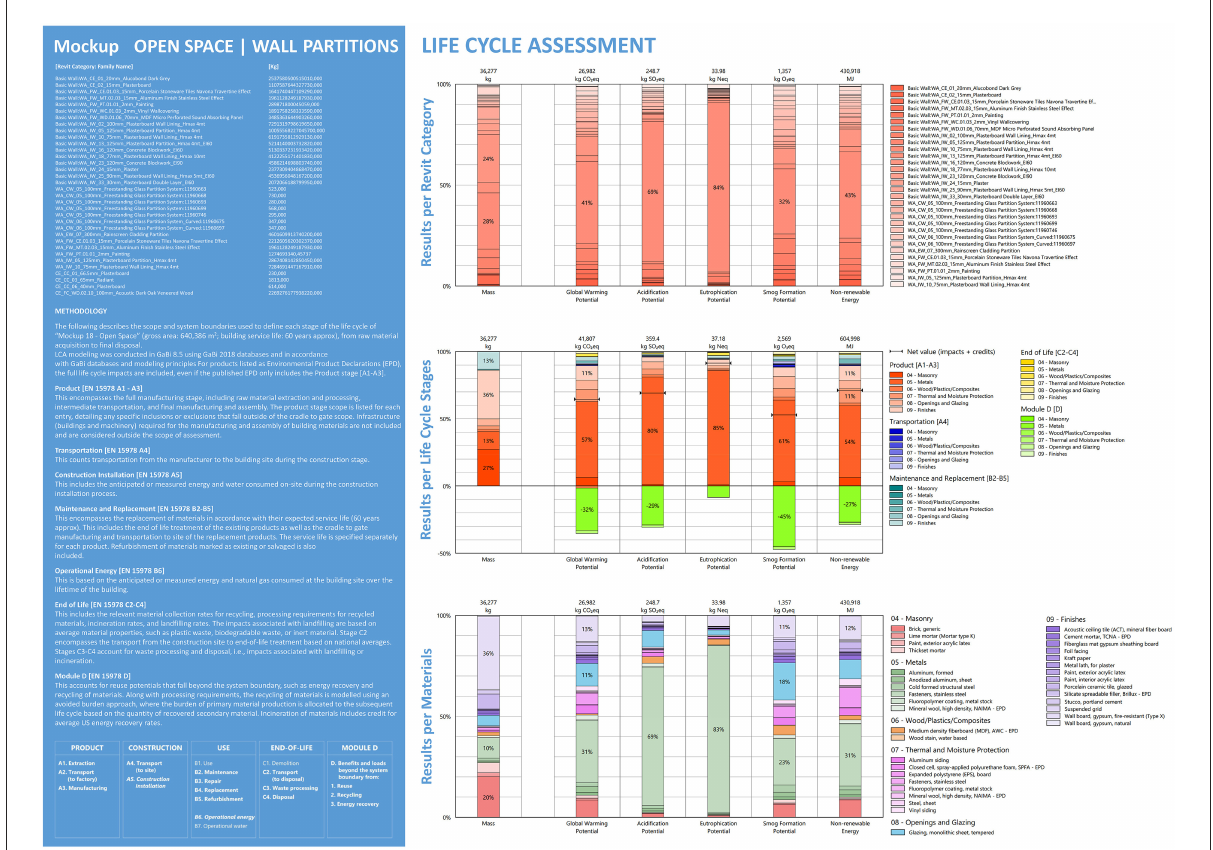
FIGURE4 LCA analysis of the interior wall partitions and finishes, categorized by Revit categories, life cycle stages, and